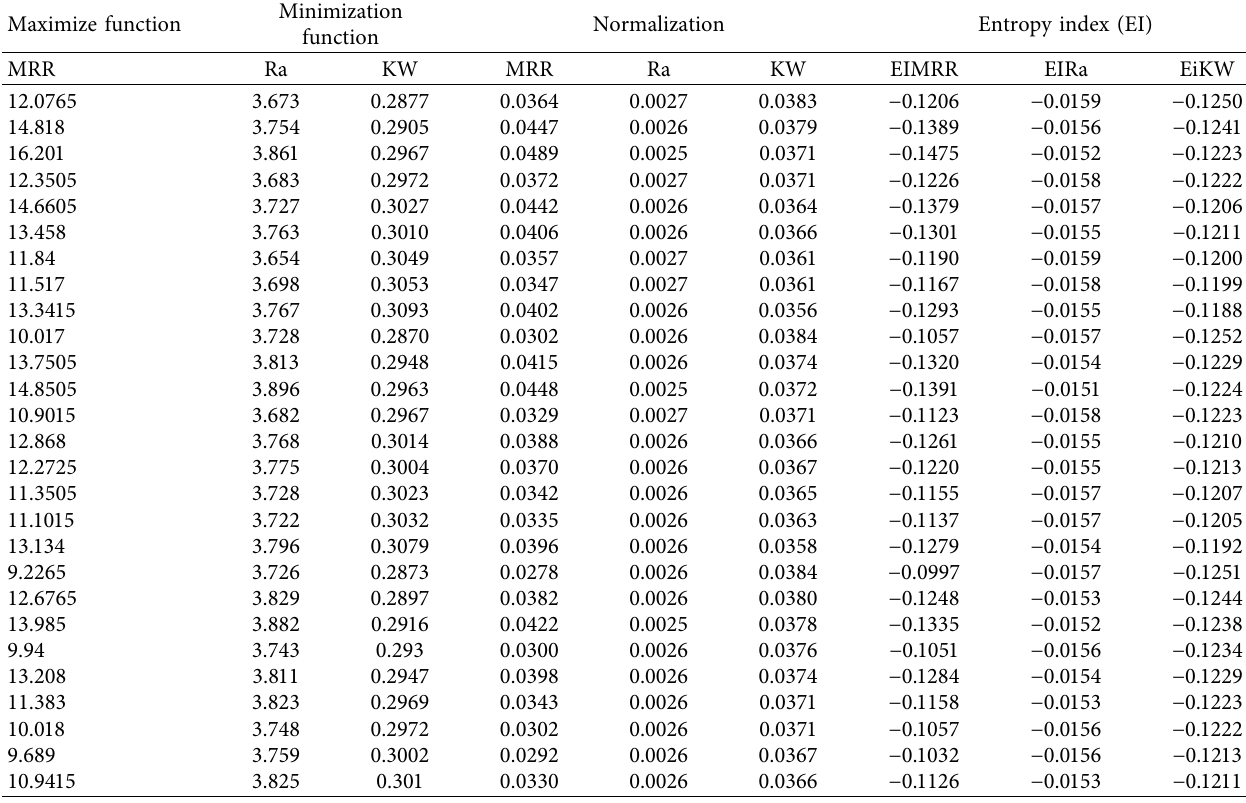
Table 9: Entropy modelling for output variables.